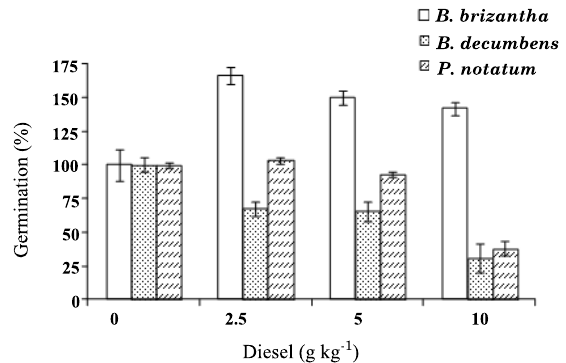
Figure 1. Seed germination of Brachiaria brizantha , Brachiaria decumbens and Paspalum notatum grown on control and diesel-treated soil (0, 2.5, 5 and 10 g kg -1 ) after three weeks of growth. Bars represent standard error of triplicates.